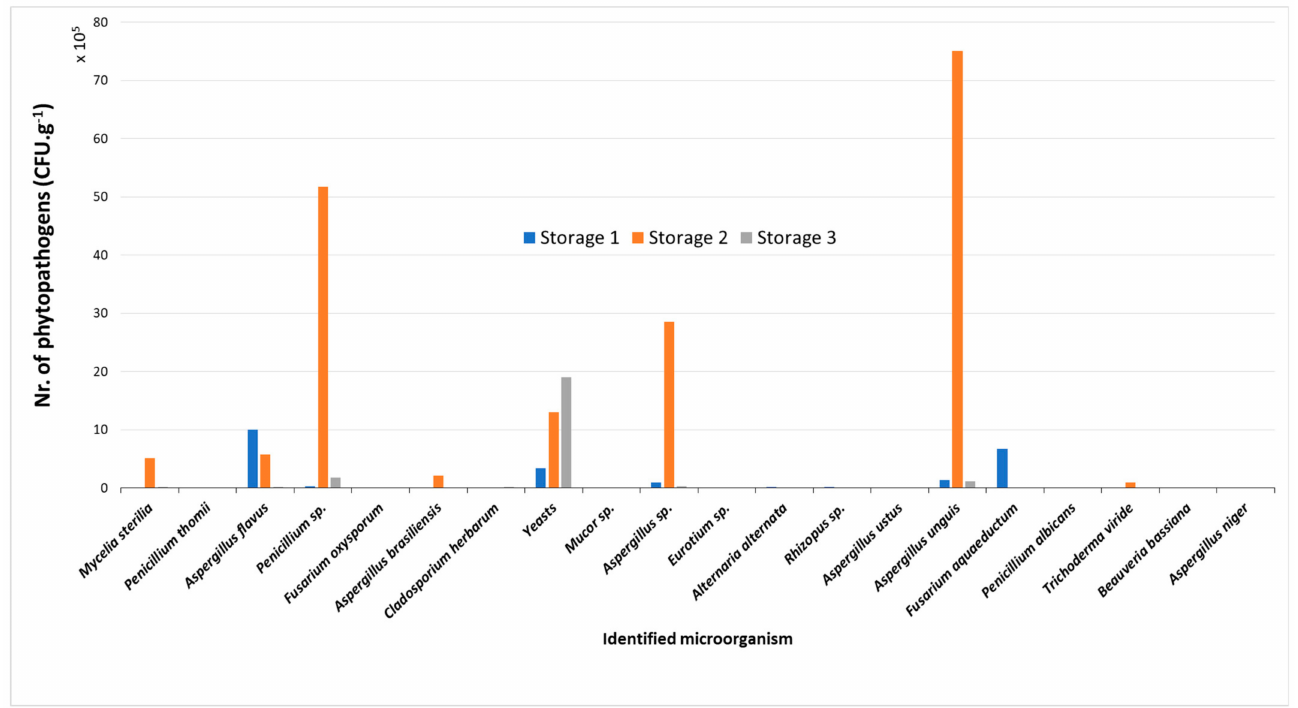
Figure 7. Identified phytopathogens and their number at individual sampling points from samples from a depth of 0.5